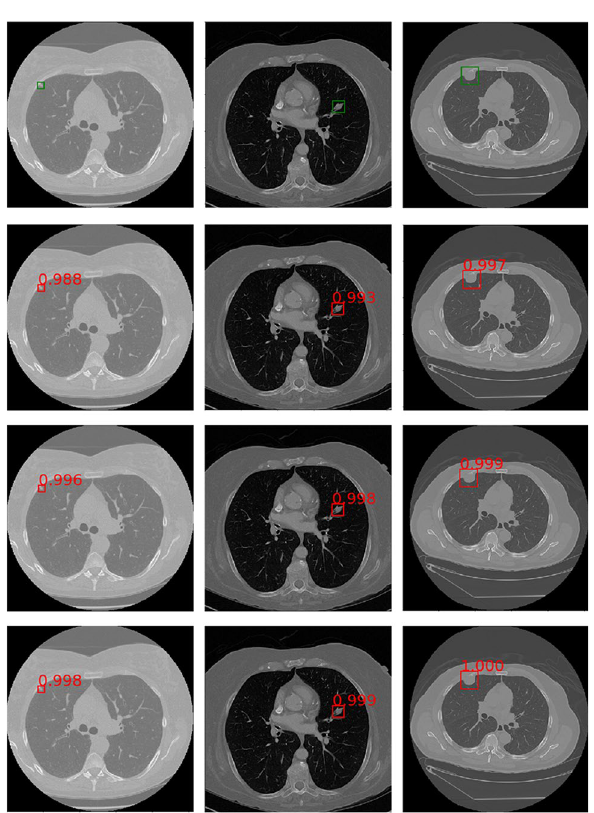
Figure 11. Detection results of nodules with different sizes on LUNA16